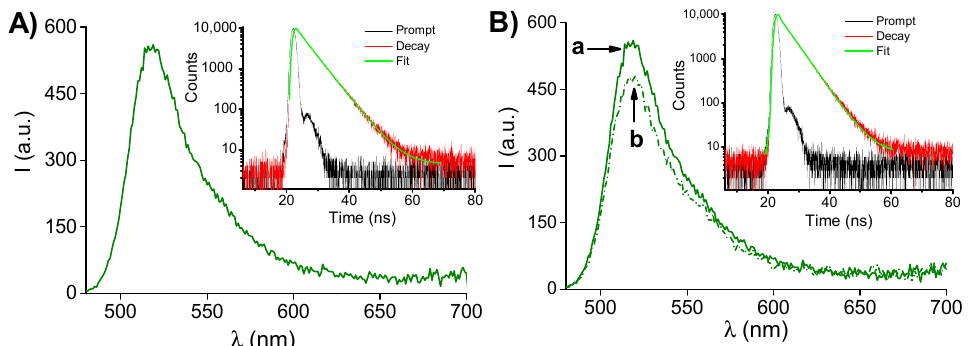
Figure 4. ( A ) Fluorescence emission spectrum ( λ exc = 470 nm) of an aqueous solution of PolyCDNO (1 mg mL − 1 ) in the presence of SRB (18 μ g mL − 1 ). The inset shows the fluorescence decay profile monitored at λ em = 530 nm. ( B ) Fluorescence emission spectrum ( λ exc = 470 nm) of an aqueous solu- tion of PolyCDNO (1 mg mL − 1 ) in the presence of SRB (18 μ g mL − 1 ) before (a) and after (b) 50 min of light irradiation at 405 nm. The inset shows the fluorescence decay profile monitored at λ em = 530 nm after 50 min of irradiation.